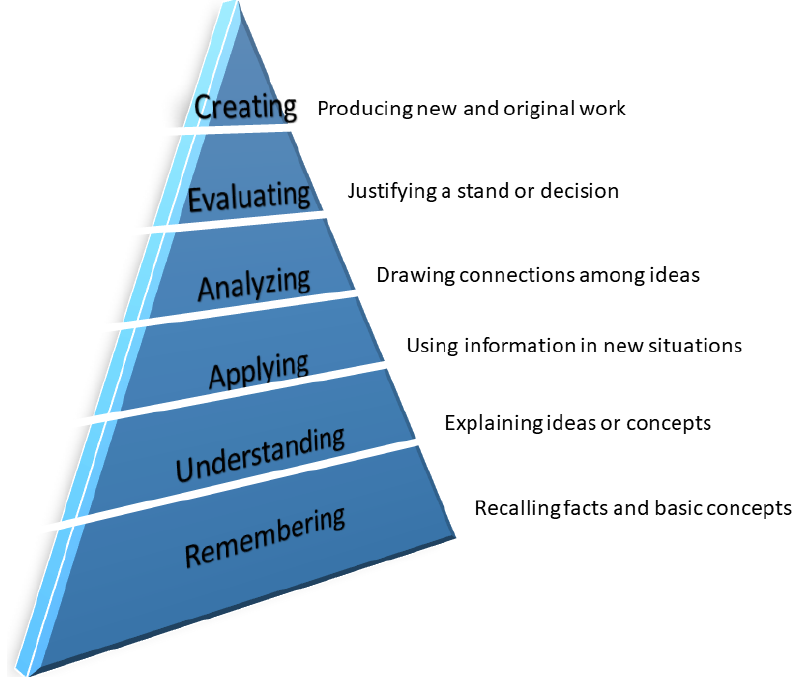
Figure 8. Updated Bloom’s taxonomy pyramid with explanations